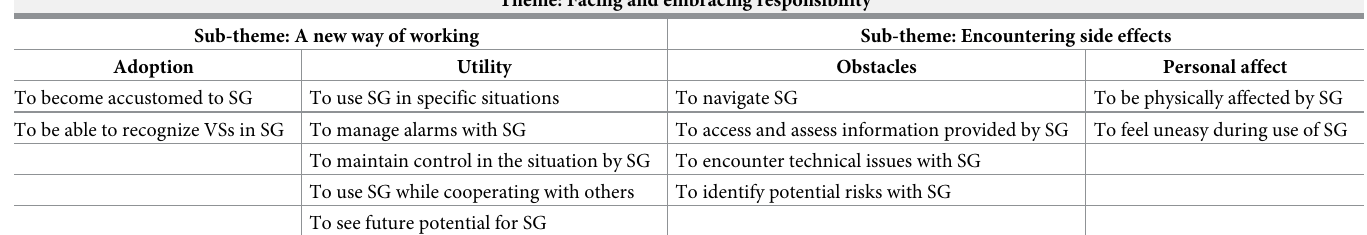
Table 3. Overview of